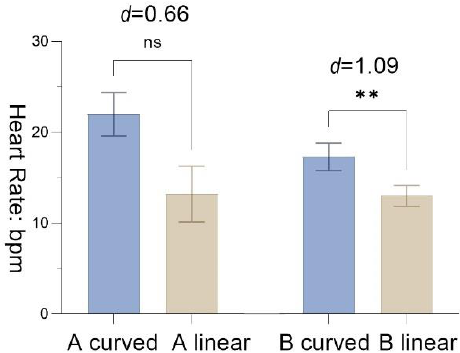
Figure 10. The results of heart rate with the standard error mean bars; significance levels: ns p > 0.05, ** p < 0.01; effect size (d): negligible (<0.2), small (0.2 – 0.5), moderate (0.5 – 0.8), and large effect